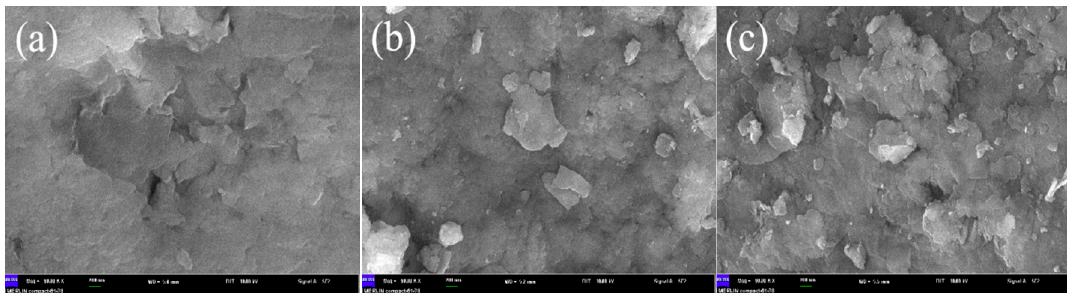
Figure 3. Variation of zeta potential with pH of ZnAl–LDH, FePcS–LDH, and FePcS–PMA–LDH.